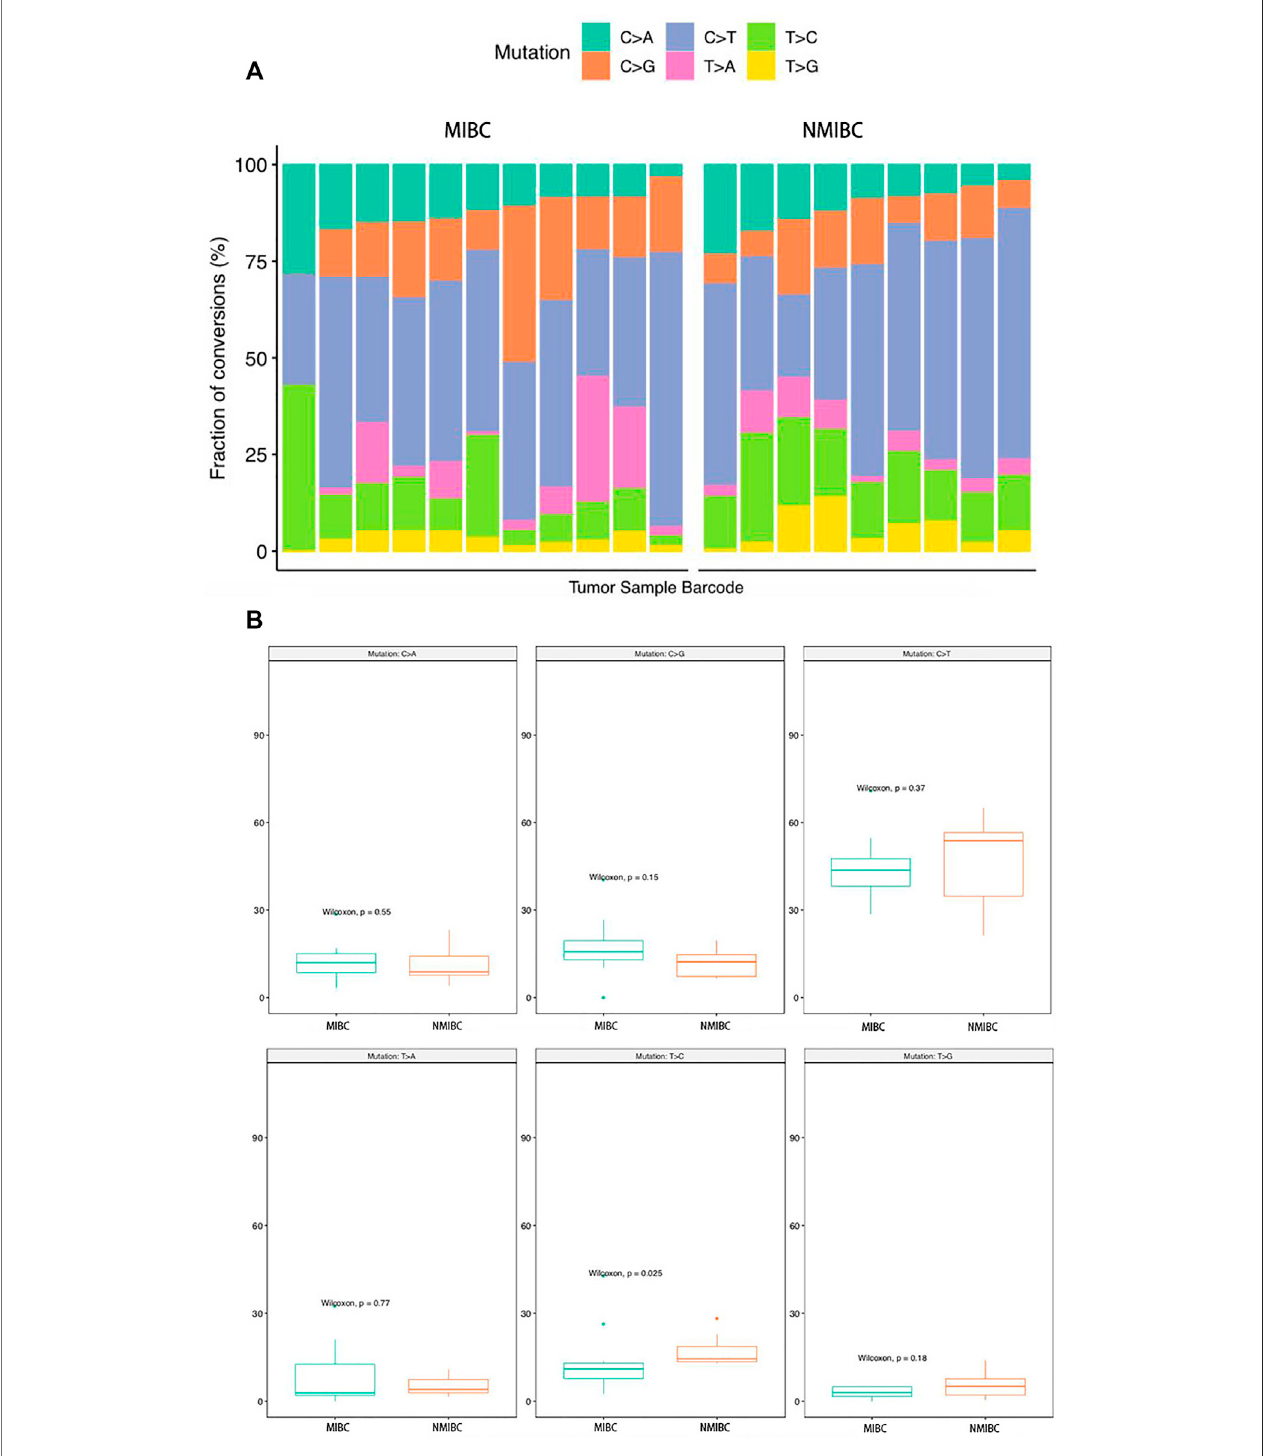
FIGURE 4 | The analysis of the SNV conversions in 20 bladder cancer samples. (A) Fraction of all types of SNV conversions in each sample of bladder cancer; (B) ComparisonofallSNVconversiontypesfractionsbetweenNMIBCandMIBCgroups,datawereexpressedasmedian(interquartilerange)andwerestatisticallyanalyzed by Mann-Whitney U test. SNV: single-nucleotide variants; NMIBC: non-muscle invasive bladder cancer; MIBC: muscle-invasive bladder cancer.